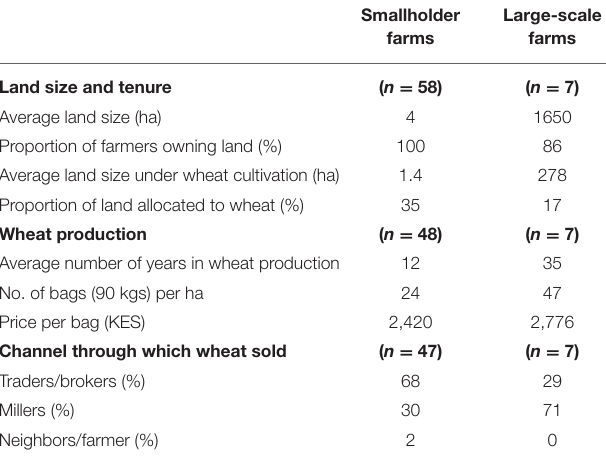
TABLE 1 | Characteristics of sampled smallholder and large-scale wheat